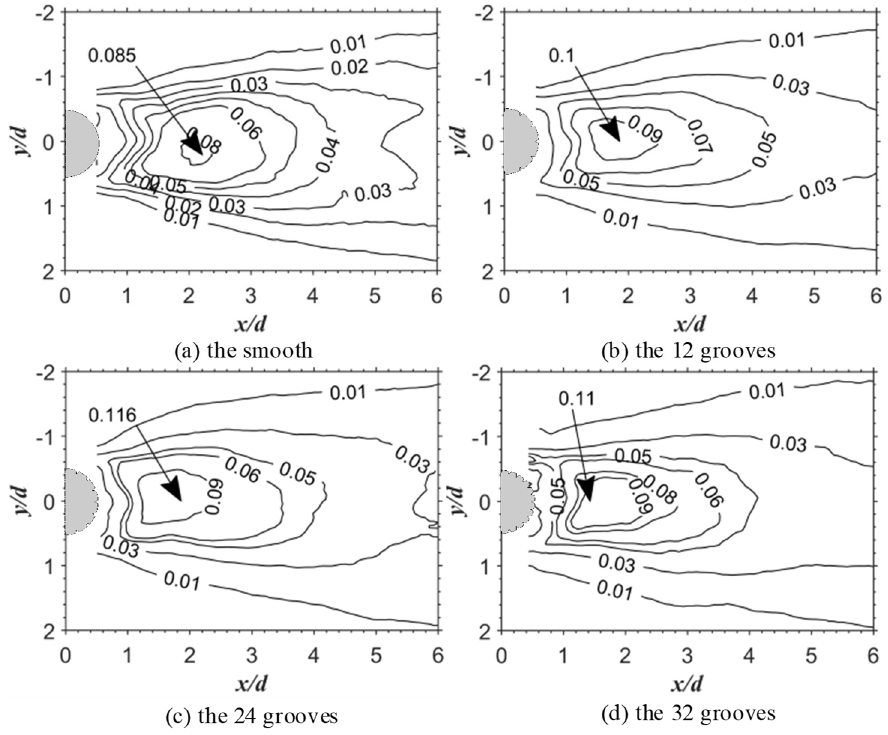
Figure 9. Contours of the turbulent kinetic energy in the ( x, y )-plane.